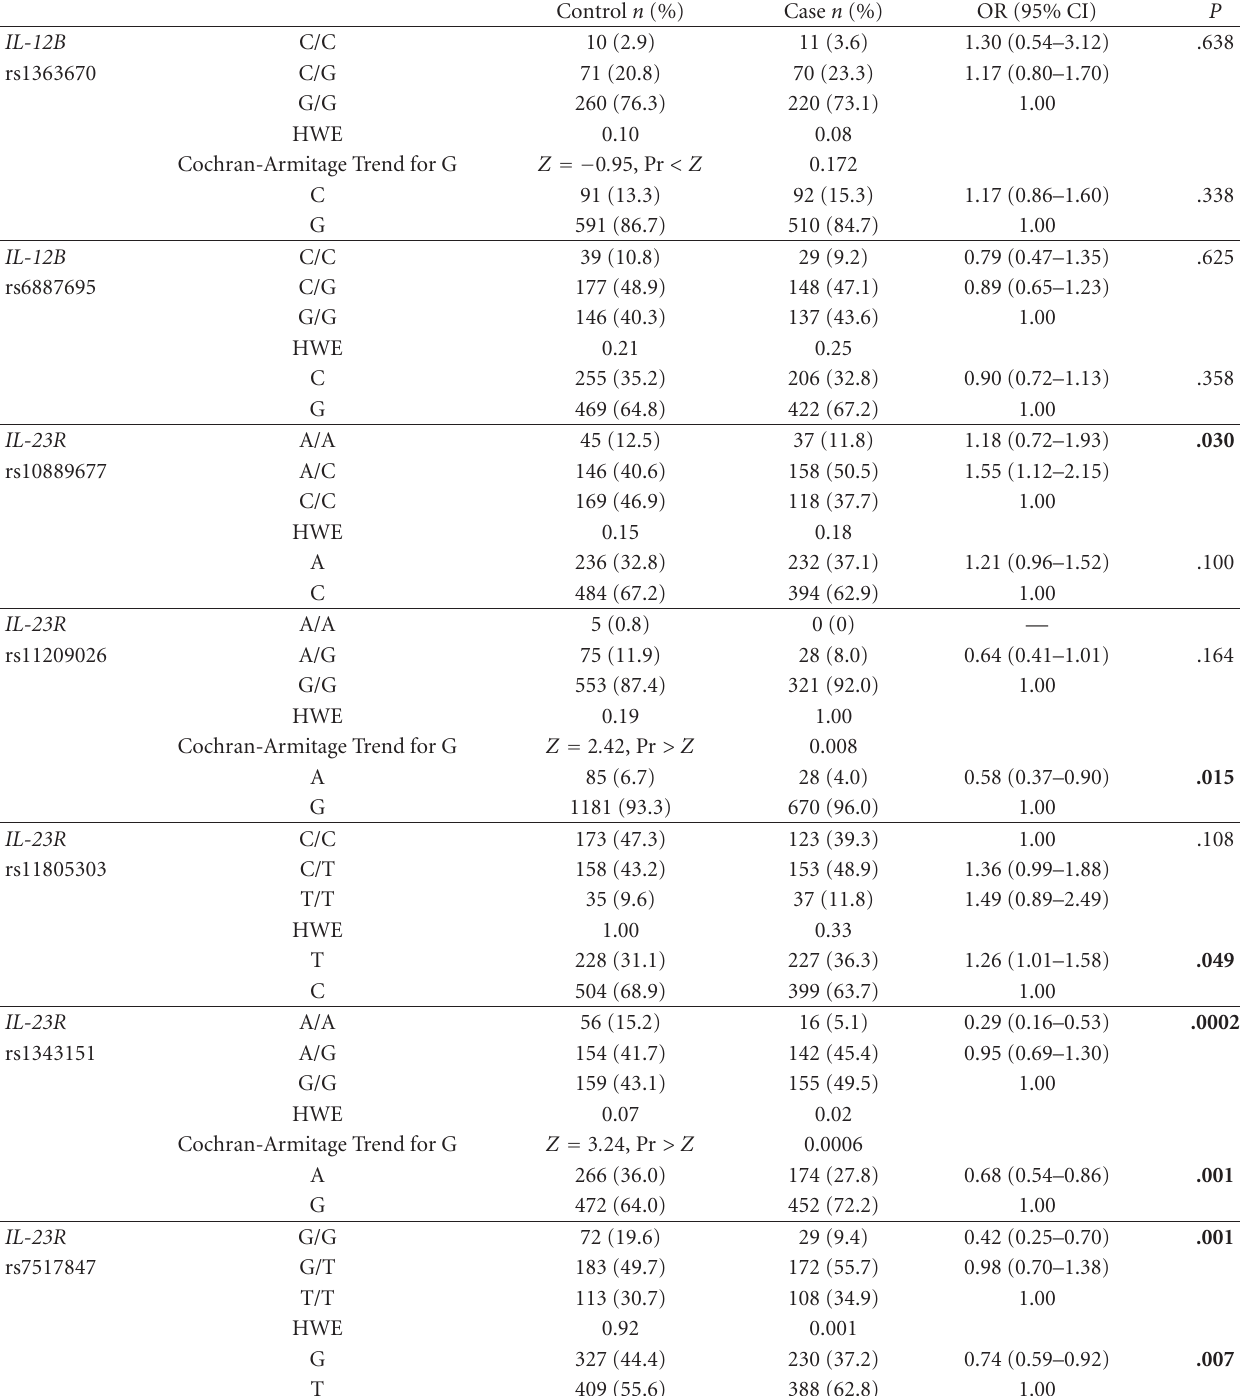
Table 2: Genotype and allele counts for IL-12B and IL-23R variants in CD patients and in Caucasian